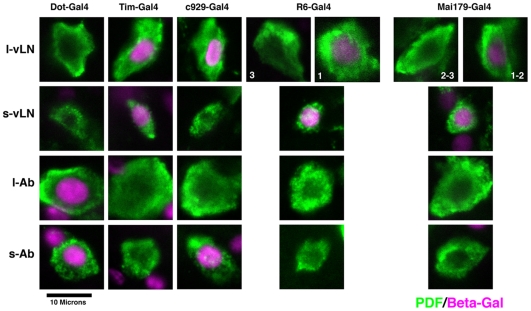
Differential expression of various Gal4 elements among the four classes of persistent adult PDF neurons.The Gal4 lines used are indicated above each column and in all cases drove uas-lacZnls expression. Neuron type is indicated on the left. Each panel is a single confocal optical section through an individual PDF neuron; anti-PDF IR is shown in green, anti-beta-galactosidase is shown in magenta. Both R6-Gal4 and Mai179-Gal4 were predominately expressed in the s-vLNs, but were often weakly expressed in one or two l-vLNs, as indicated by the numbers in the top row of optical sections.